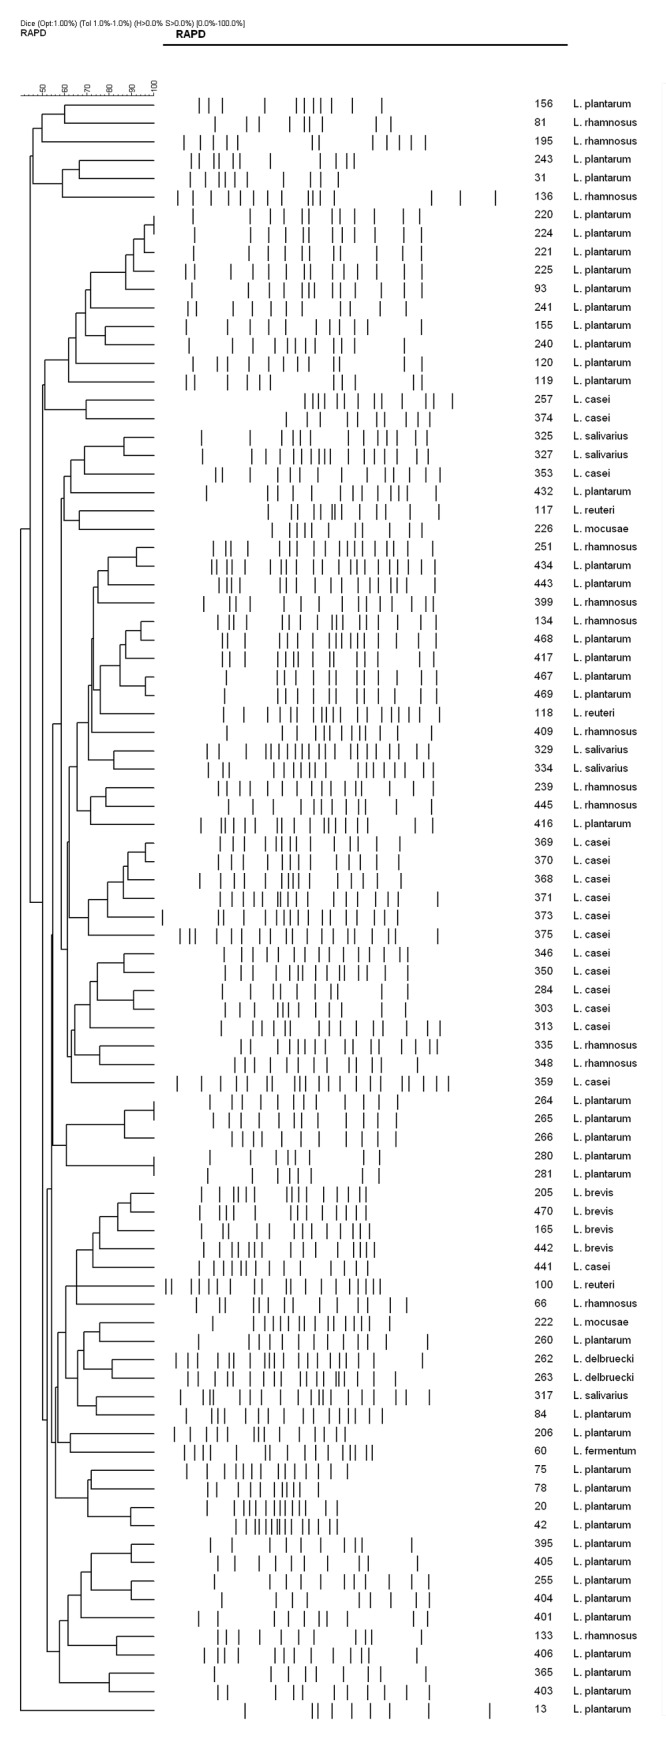
Genotypic clustering of isolated Lactobacillus sp. with RAPD PCR assay.